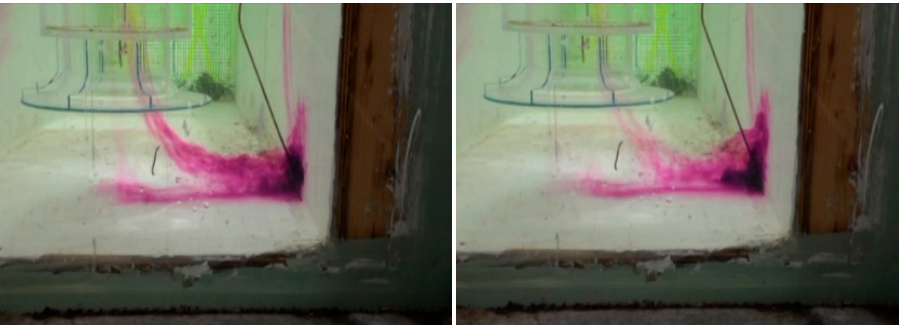
Figure 11. Intermittent side wall vortex. Type 1 to occasional type 3. Combined with the floor vortex increases the swirl along the pump column.